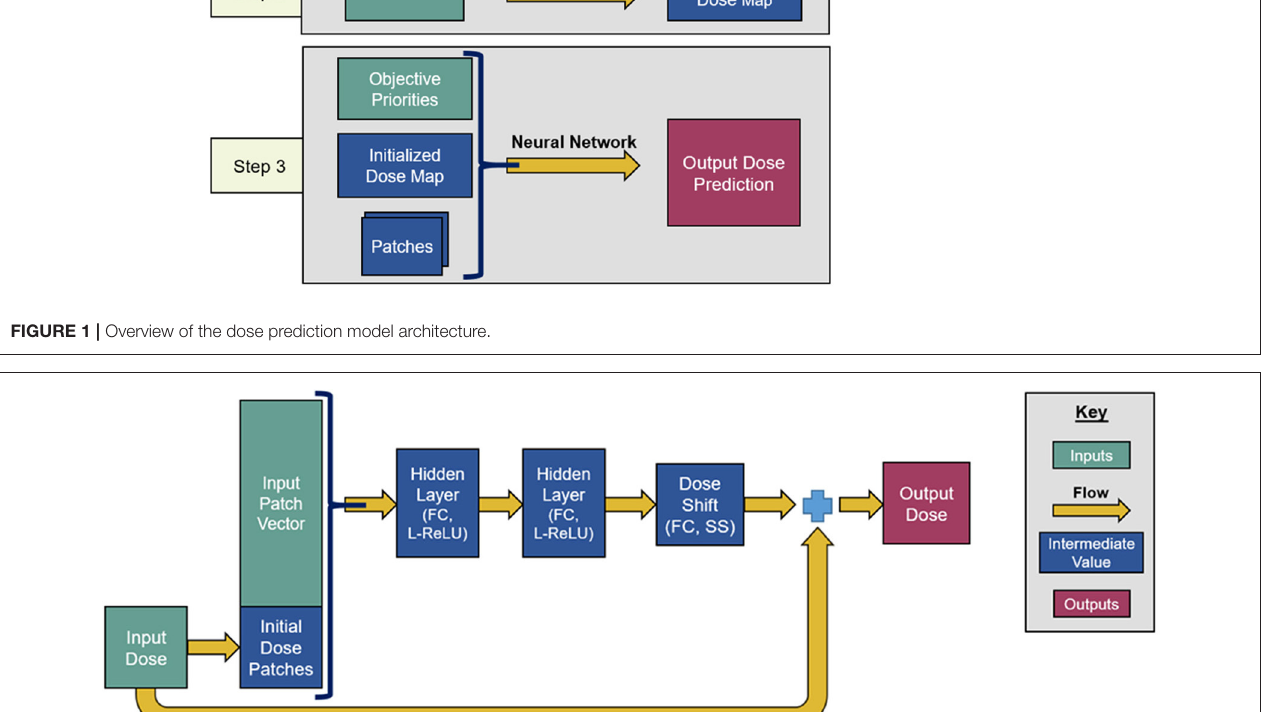
layers have 100 output units and leaky rectified linear unit